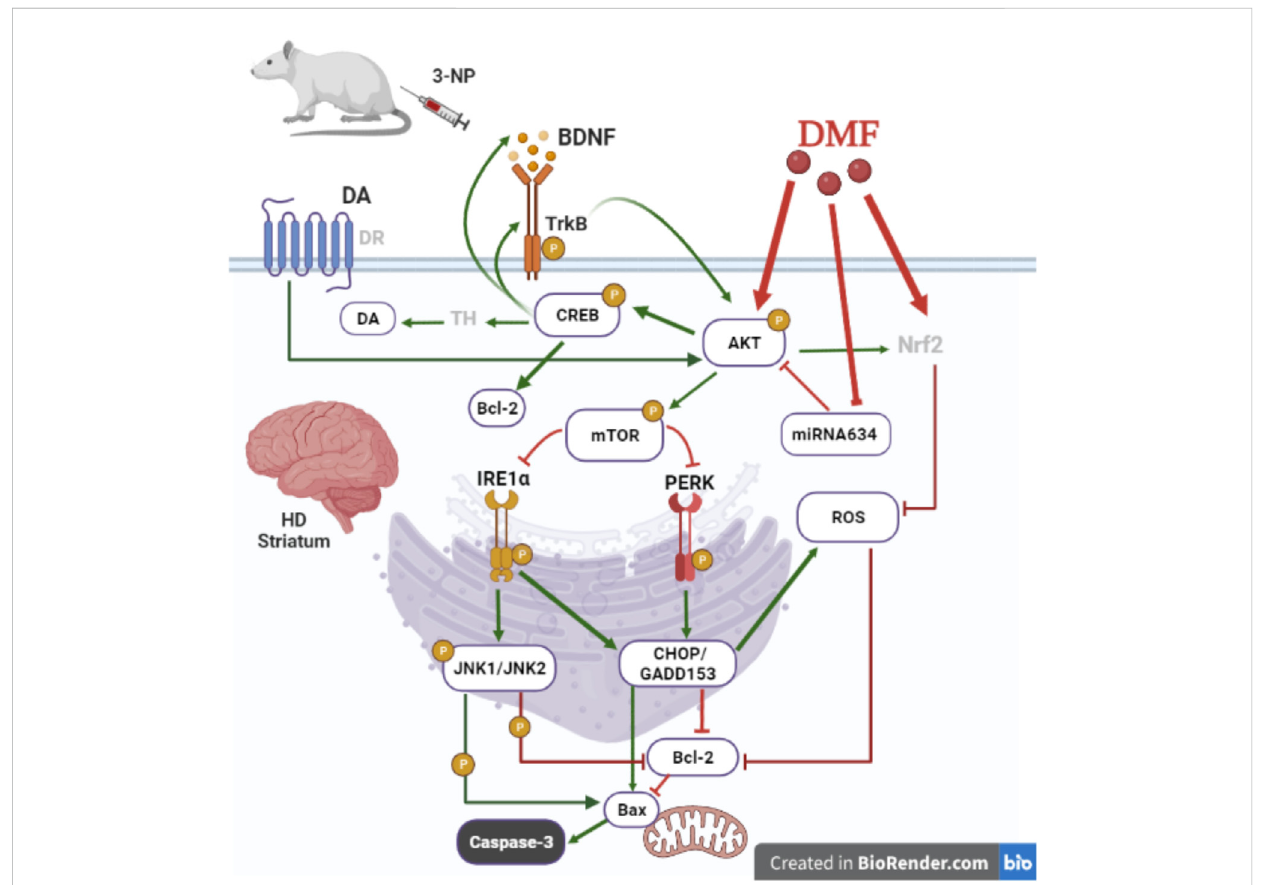
FIGURE 7 Proposed mechanism for DMF therapeutic ef fi cacy inmanaging HD-induced motor dysfunction. DMF ameliorates striatal lossof neurons in a3-NP induced HD model by 1) inducing AKT/mTOR activation to inhibit intrinsic apoptosis caused by both ER stress arms IRE1 α /JNK and PERK/CHOP/ GADD153 activation; 2) activating the BDNF/TrkB/AKT/CREB axis to overweigh the pro-survival Bcl-2 and enhance DA formation; 3) downregulating miRNA-634 to initiate AKT activation; and 4) suppressing the oxidative stress response consequent to CHOP/GADD153 inhibition to additionally suppress intrinsic apoptosis. AKT, protein kinase B, Bax, B-cell lymphoma-2-associated X; Bcl-2, B-cell lymphoma-2; BDNF, brain-derived neurotrophic factor; CHOP/GADD153, C/EBP homologous protein; CREB, cAMP response element-binding protein; DA, dopamine; DMF, dimethyl fumarate; DR, dopamine receptor; HD, Huntington ’ s disease; IRE1 α , inositol-requiring enzyme 1 alpha; JNK, c-Jun NH2-terminal kinase; miRNA-634, microRNA-634; mTOR, mammalian target of rapamycin; 3-NP, 3-nitropropionic acid; Nrf2, nuclear factor (erythroid-derived 2)-like 2; PERK, protein kinase R-like endoplasmic reticulum kinase; ROS, reactive oxygen species; TH, tyrosine hydroxylase; TrkB, tropomyosin receptor kinase B. This fi gure is created in